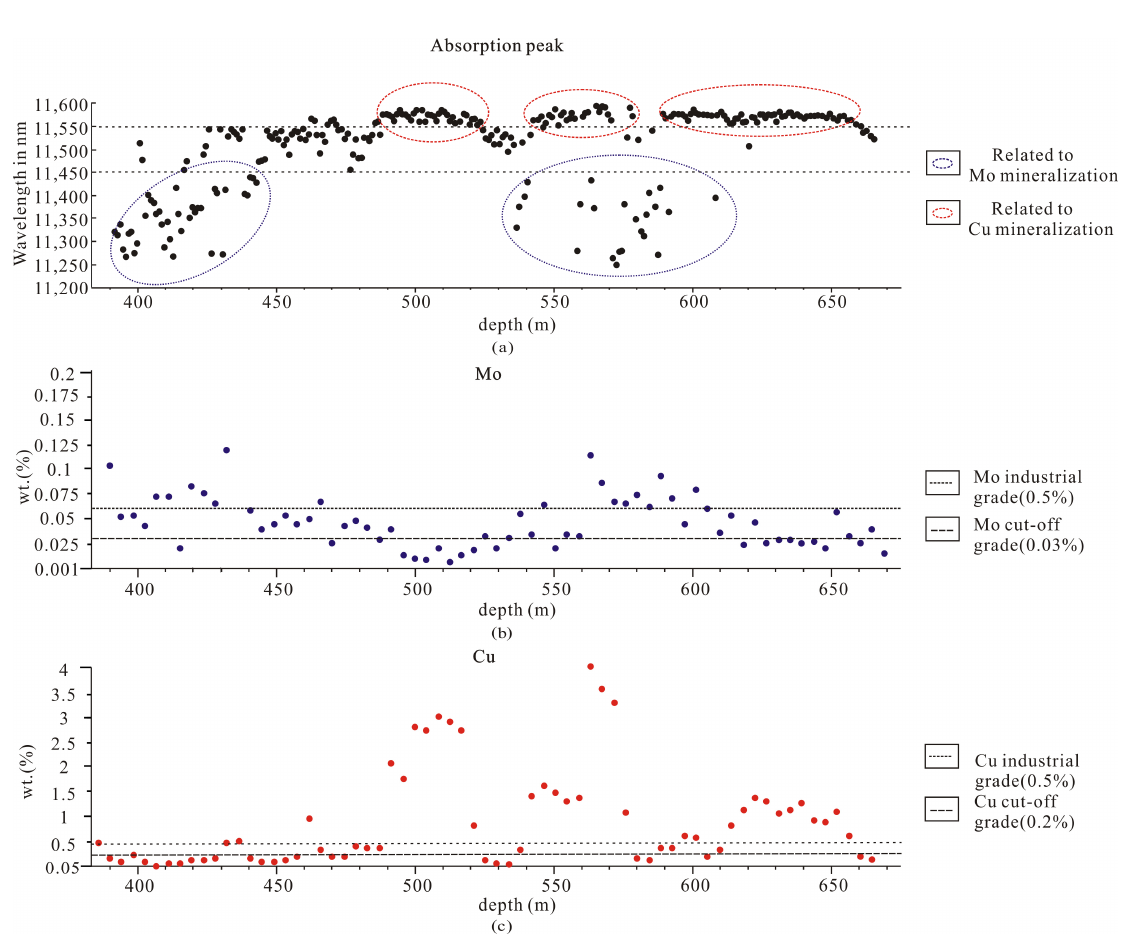
Figure 11. Comparison of garnet wavelength versus Cu, Mo content. ( a ) Variation of garnet spectral absorption peak down the drill hole, ( b ) Mo grade changes down the drill hole, ( c ) Cu grade changes down the drill hole.